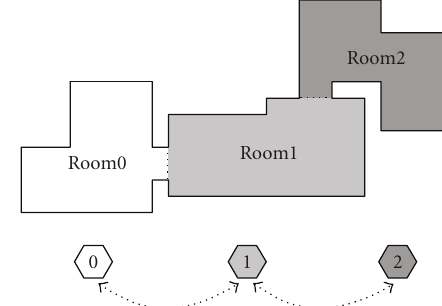
Figure 3: The scenery is split into three rooms, which are repre- sented by the nodes of the scene graph (denoted through hexagons). The rooms are connected to their neighboring rooms by 2 por- tals (room0/room1 and room1/room2, denoted through the dotted